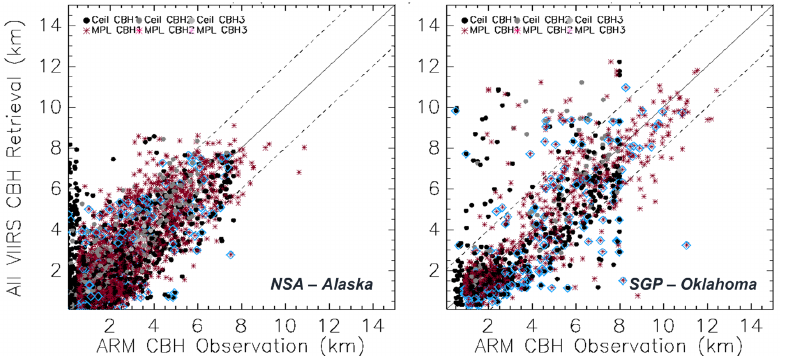
Figure 5. CBH comparisons of VIIRS and ground-based data from Ceilometer (black and gray for layers) and Micro-Pulse Lidar (red and brown) collected from an Atmospheric Radiation Measurement (ARM) Alaska NSA site ( left ; 2285 cases) and Oklahoma SGP site ( right : 770 cases) for 2019–2021. Note that matchups are valid only when CTH from lidar (MPL) is within a 2 km accuracy range compared with VIIRS CTH (“within-spec”). Dotted lines represent 2 km error ranges, and CBHs from a nighttime cloud optical property algorithm (NLCOMP) using DNB are colored in blue.